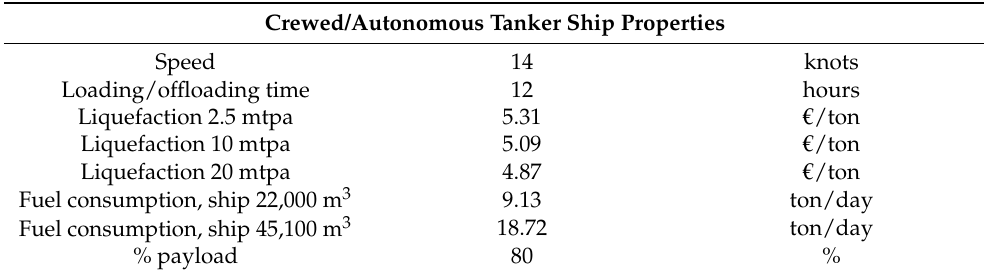
Table 13. Crewed/autonomous tanker ship properties, data is analyzed and summarized from